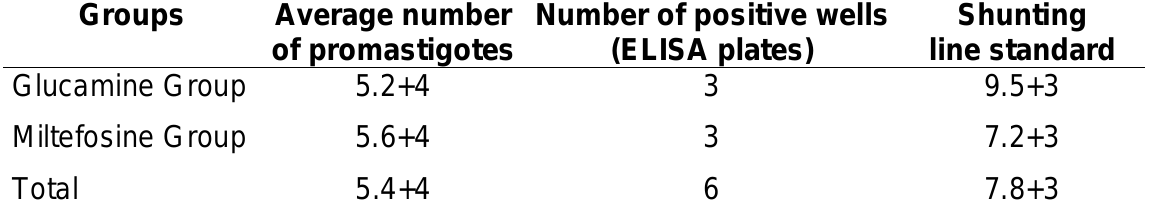
Table 1. Average number of promastigotes calculated using limiting dilution assay in mice treated with N-methyl glucamine only (Glucamine Group) and with N-methyl glucamine plus topical miltefosine (Miltefosine Group);